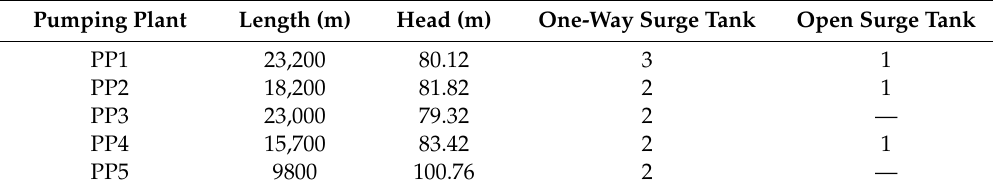
Table 1. Characteristics of the five pipeline segments.